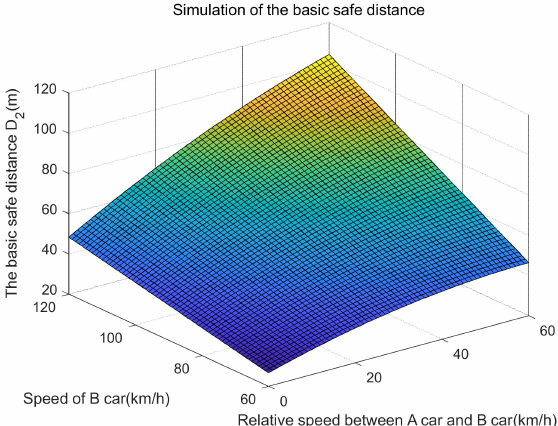
Figure 10. Changes in the basic safe distance D 2 with various V B and V r when i = − 0.3 and d = 5.